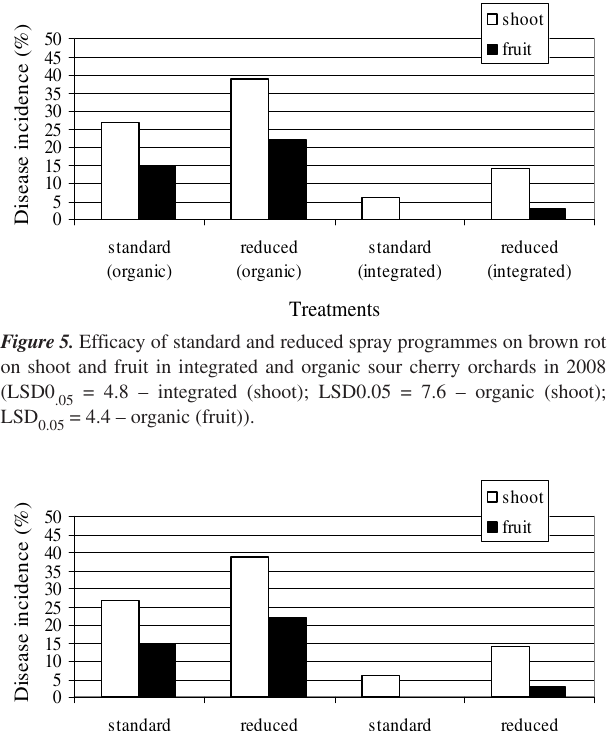
= 9.4 – organic (shoot); LSD 0.05